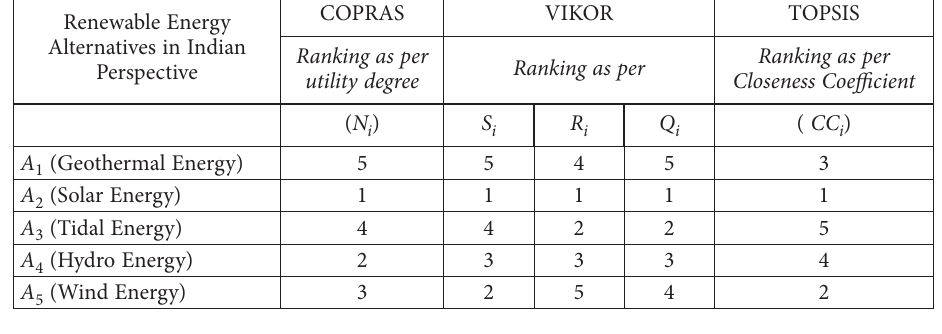
Table 13. Comparison of COPRAS with other MCDM methods Renewable Energy Alternatives in Indian